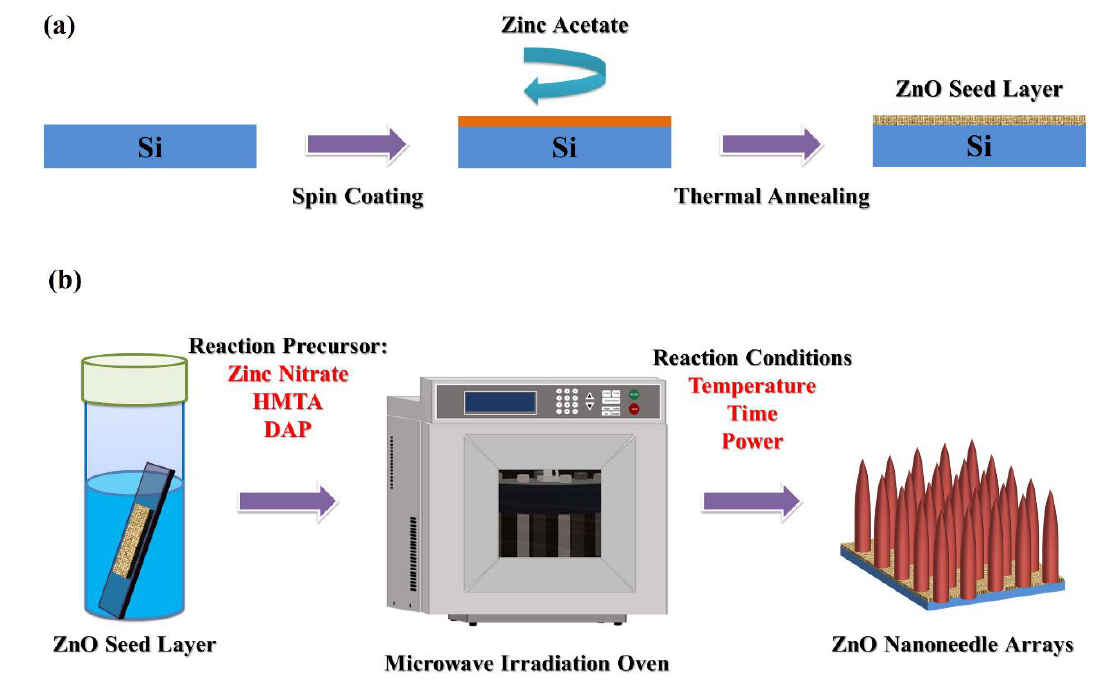
Figure 1. The schematically illustrates the fabrication of ( a ) ZnO seed layer and ( b ) ZnO nanoneedle arrays.